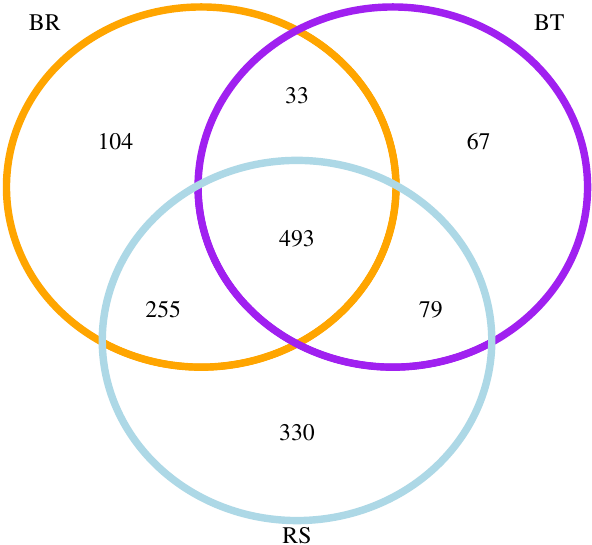
Figure 2. Venn diagram showing the number of unique and shared bacterial OTUs among field-collected leaf samples from the association between the model tree Rhaphithamnus spinosus and the mimetic vine Boquila trifoliolata . Groups: RS = leaves from R. spinosus [sky blue], BR = Boquila leaves mimicking the tree leaves [orange], and BT = Boquila leaves from the same individual vine but not mimicking the tree leaves [purple].